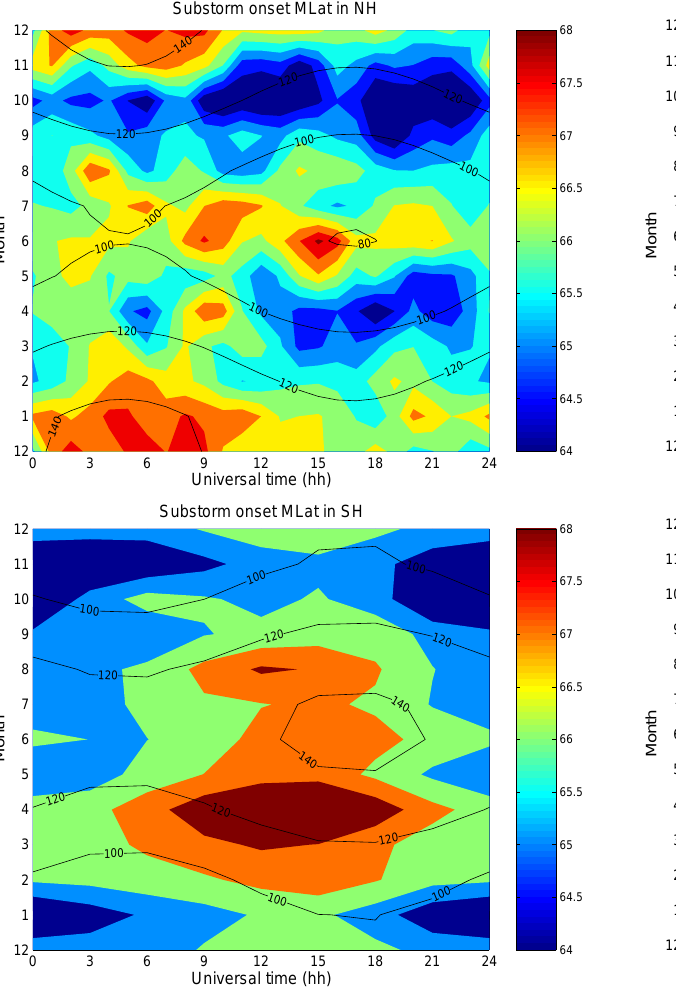
Fig. 6. Distribution of substorm onset magnetic latitude versus month and universal time for both hemispheres. Overplotted are SZA contours for the location 66.5 ◦ MLat and 23:00 MLT.